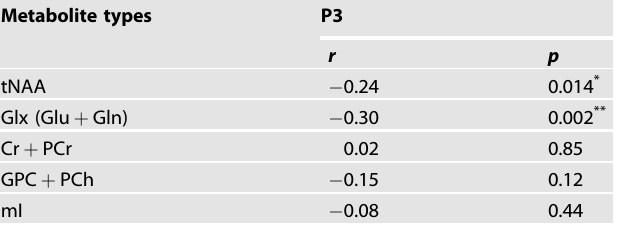
Table 4. Partial correlation analysis between the score of P3 hallucination item of PANSS and the type of